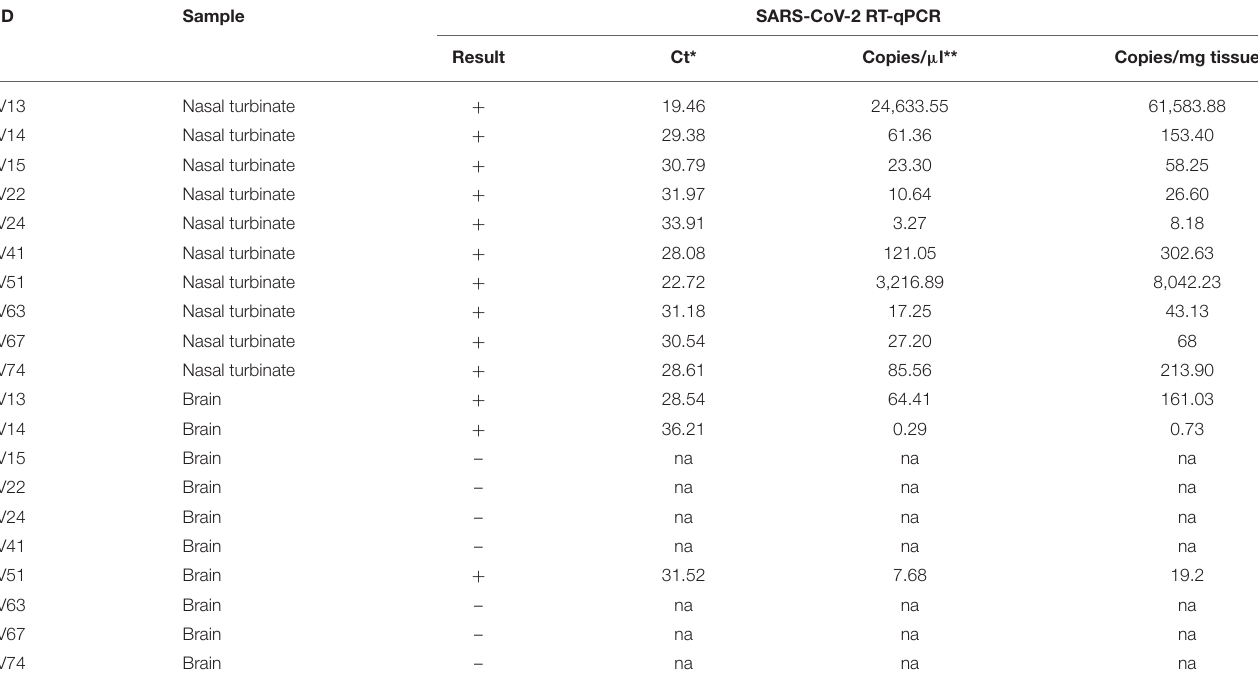
TABLE 1 | SARS-CoV-2 RT-qPCR results obtained from nasal turbinate and brain samples of mink from a Spanish farm.